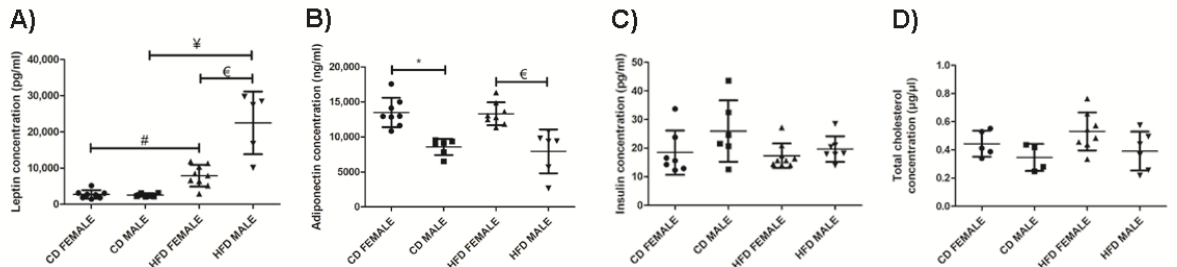
Figure 10. Plasma leptin concentration (pg/mL), ( A ); plasma adiponectin concentration (ng/mL), ( B ); plasma insulin concentration (pg/mL), ( C ); and total cholesterol ( µ g/ µ L), ( D ); measured in CD females, CD males, HFD females and HFD males. * Significant difference between the CD females and CD males, p < 0.05. # Significant difference between CD female and HFD female, p < 0.05. ¥ Significant difference between CD male and HFD male p < 0.05. € Significant difference between HFD female and HFD male, p < 0.05. Mean ± SD. Black circle, triangle and square represent individual data points in the different categories CD females, CD males, HFD females and HFD males on the x-axis.